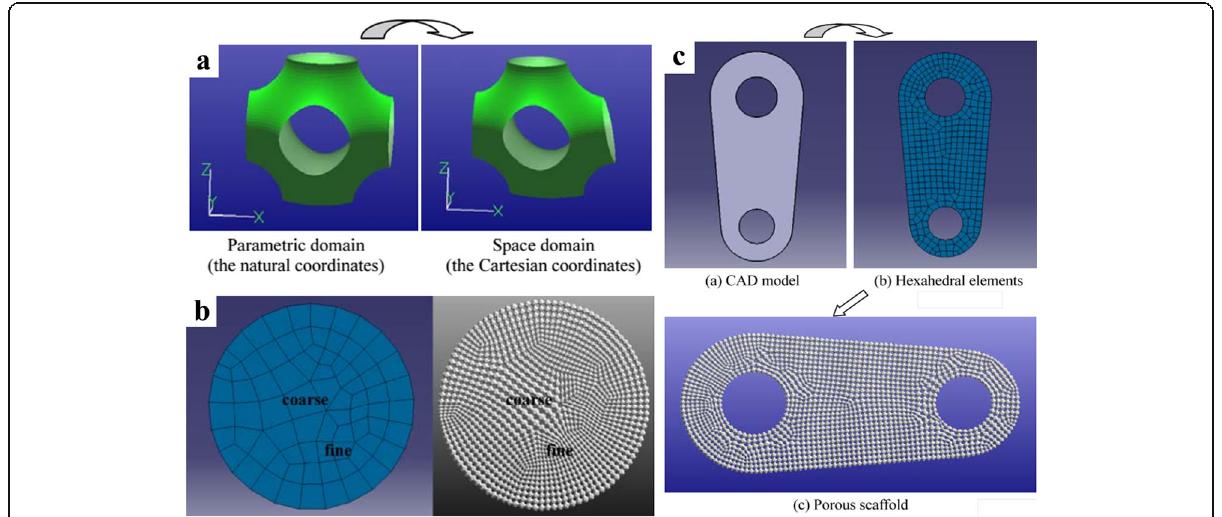
Fig. 14 Porous scaffold design by the shape function and TPMS: a The mapping method. b Mesh division. c The generated TPMS scaffold [34]